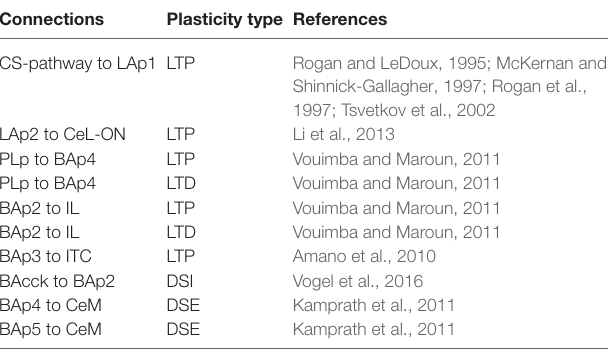
TABLE 1 | Plastic connections of the model.